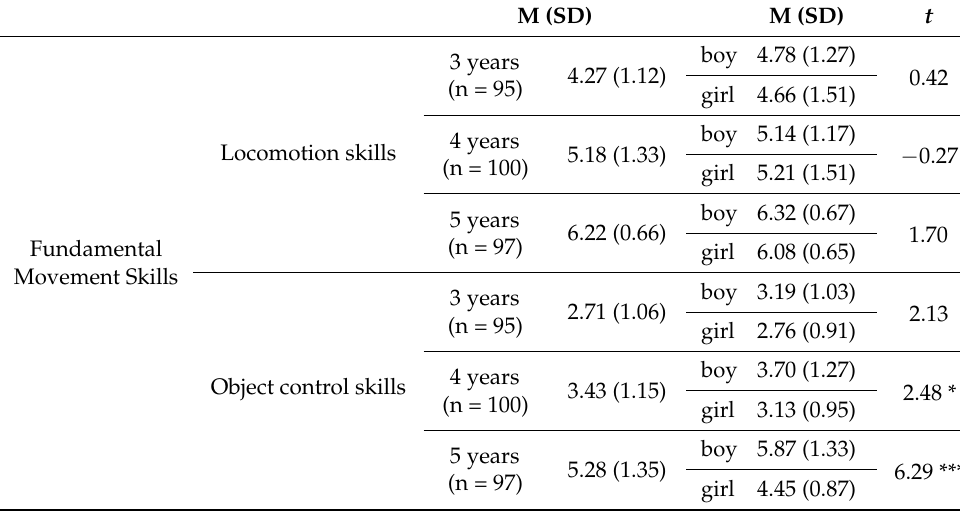
Table 1. FMS score by age and gender (n = 292).